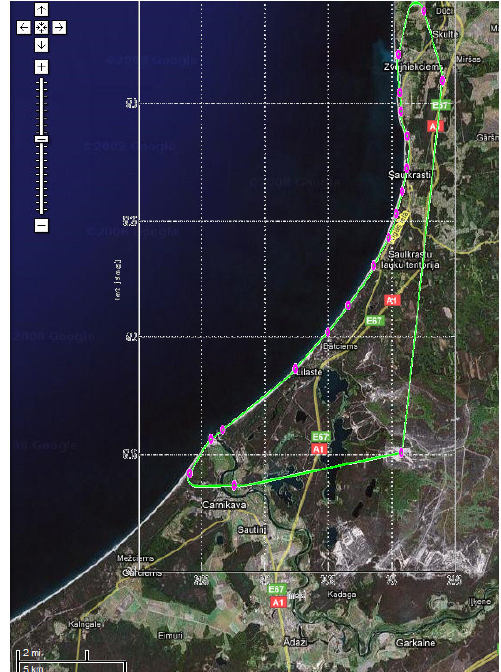
Fig 17. Defined waypoints (magenta circles) and the ground track of the UAV vehicle following a route along the coastline (green). Ground track plotted on a map provided by Google Maps